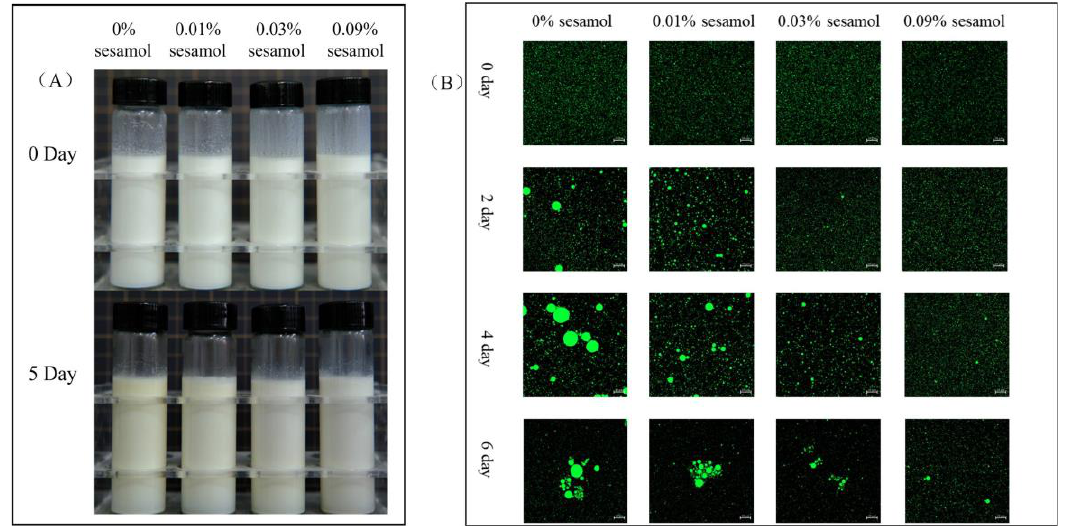
Figure 2. The effects of sesamol on the visual appearance ( A ) (from left to right: 0% sesamol, 0.01% sesamol, 0.03% sesamol and 0.09% sesamol) and emulsions’ confocal micrographs ( B ) (30 mL of emulsion in a 50 mL glass bottle with screw cap stored at room temperature and protected from light).